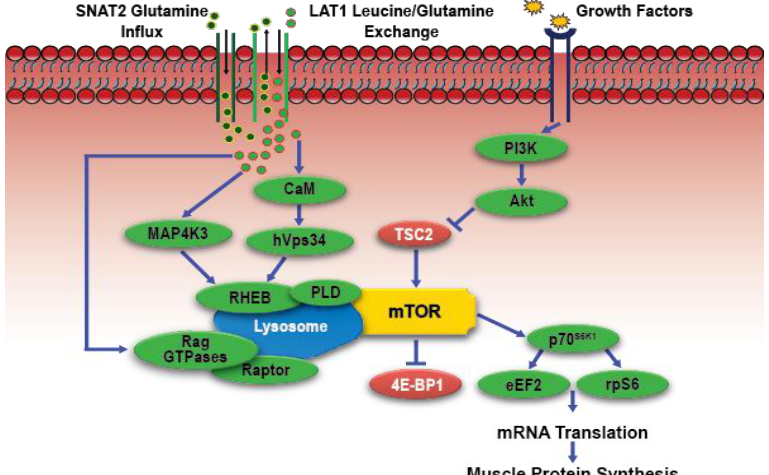
Stimulators of muscle protein synthesis depicted in green, whereas inhibitory proteins are depicted in red. Abbreviations: SNAT2, sodium-coupled neutral AA transporters; LAT1, L -type amino acid transporter 1; CaM, calcium/calmodulin; MAP4K3, mitogen activated protein kinase kinase kinase kinase-3; hVps34, human vacuolar protein sorting-34; PI3K, phosphatidylinositol 3-kinase; Akt, protein kinase B; TSC2, tuberous sclerosis complex; RHEB, Ras homolog enriched with brain; PLD, phospholipase D; RAG GTPases, Rag subfamily of Ras small GTPases; mTOR, mammalian target of rapamycin; 4E-BP1, eukaryotic initiation factor 4E-binding protein 1; p70 S6K1 , 70-kDa ribosomal protein S6 kinase 1; eEF2, eukaryotic elongation factor 2; rpS6, ribosomal protein